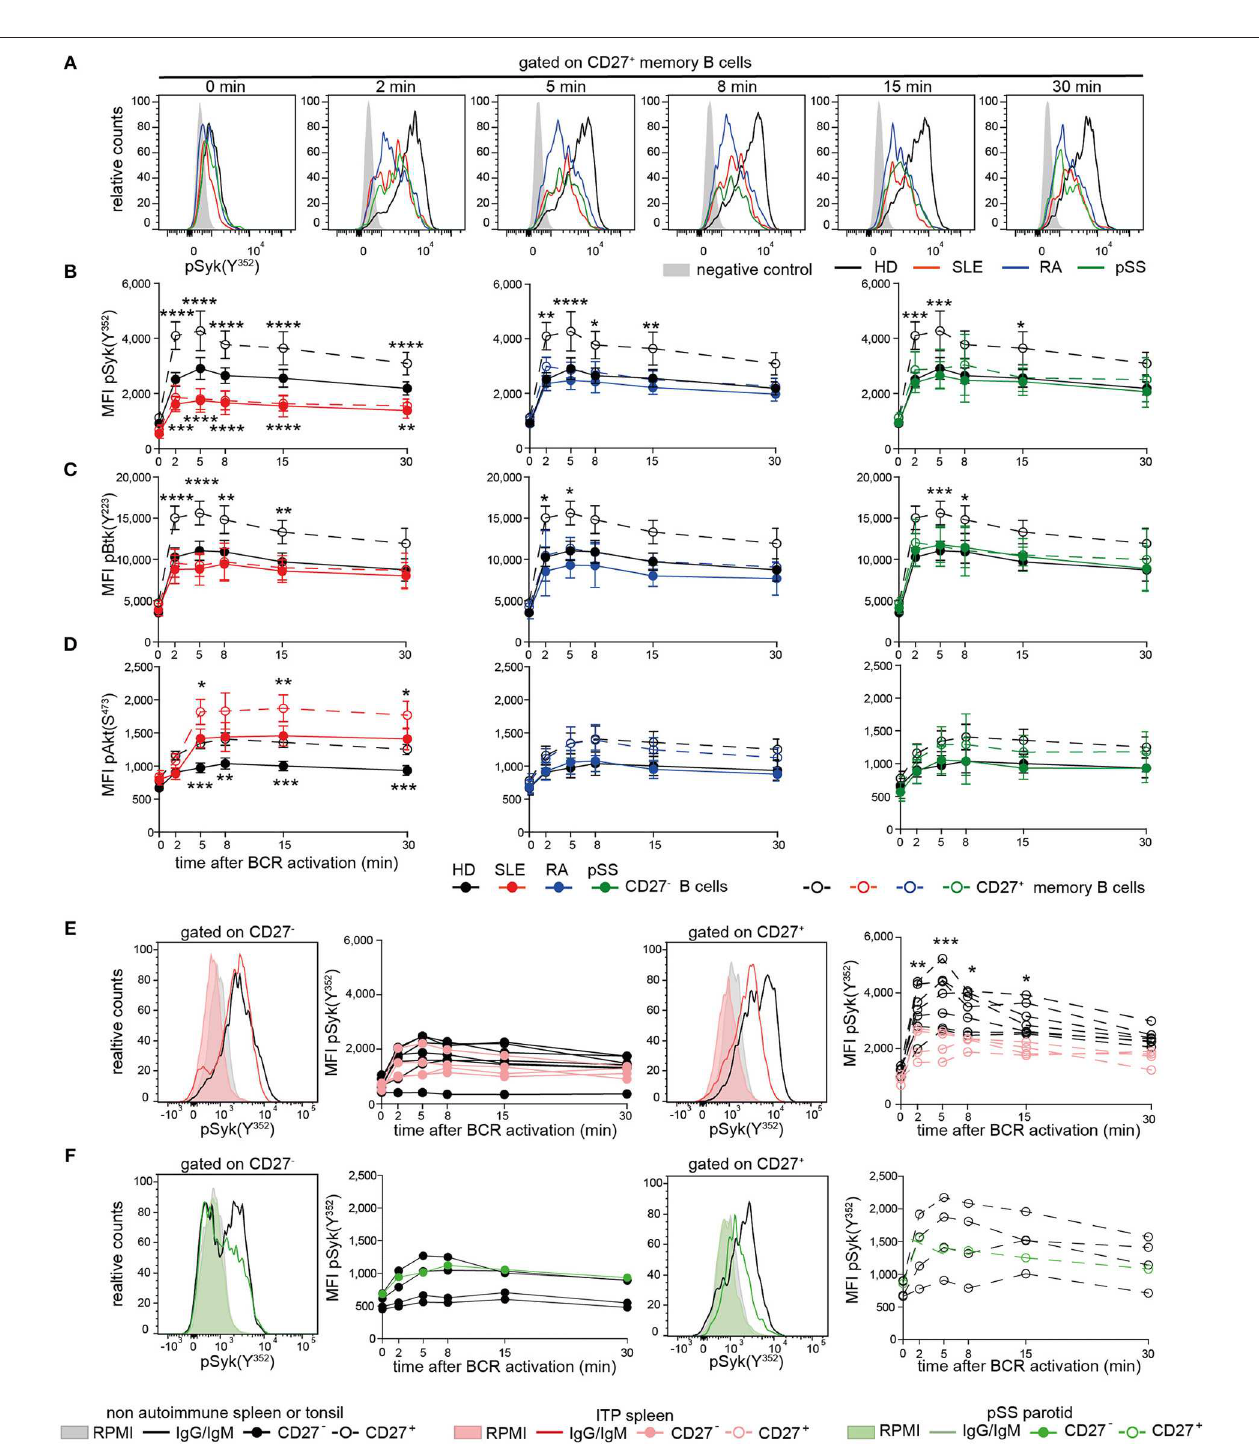
FIGURE 2 | Reduced PTK phosphorylation upon BCR signaling in peripheral and tissue-resident CD27 + B cells from patients with AID. PBMCs or MNCs from HD (black), SLE (red), RA (blue), pSS (green), and ITP (pink) vs. non-ITP (black) spleens and pSS parotid gland (green) vs. tonsils (black) were stimulated with anti-IgG/IgM F(ab) 2 . (A) Representative pSyk(Y 352 ) histograms from CD27 + memory B cells are shown. CD3 + T cells served as control (gray). Phospho-kinetics of (B) Syk(Y 352 ) [n(HD/SLE/RA/pSS) = 19/11/11/10], (C) Btk(Y 223 ) [n(HD/SLE/RA/pSS) = 21/10/6/14], and (D) Akt(S 473 ) [n(HD/SLE/RA/pSS) = 29/15/11/10] in CD27 + memory (dashed lines) and CD27 − (solid lines) B cells are shown. Phospho-Syk(Y 352 ) kinetics in B cells from (E) spleen and (F) tonsil/parotid with representative histograms [n spleens (non-ITP/ITP) = 7/4; n(tonsils/parotid) = 4/1]. Histograms show unstimulated (filled areas) vs. stimulated (solid lines) cells. Data show mean ± 95% CI (two-way ANOVA with BMCT for the comparison of AID vs. HD CD27 − or CD27 + memory B cells, respectively; * p ≤ 0.05, ** p ≤ 0.01, *** p ≤ 0.001, **** p ≤ 0.0001).